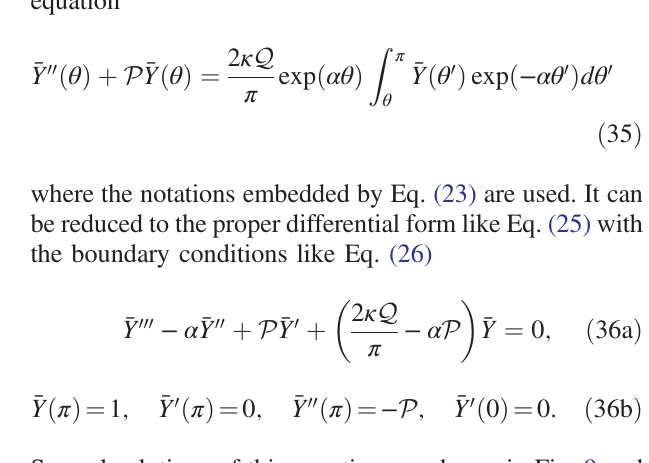
FIG. 7. Lowest real eigennumbers of the resistive wall wake, Eq.